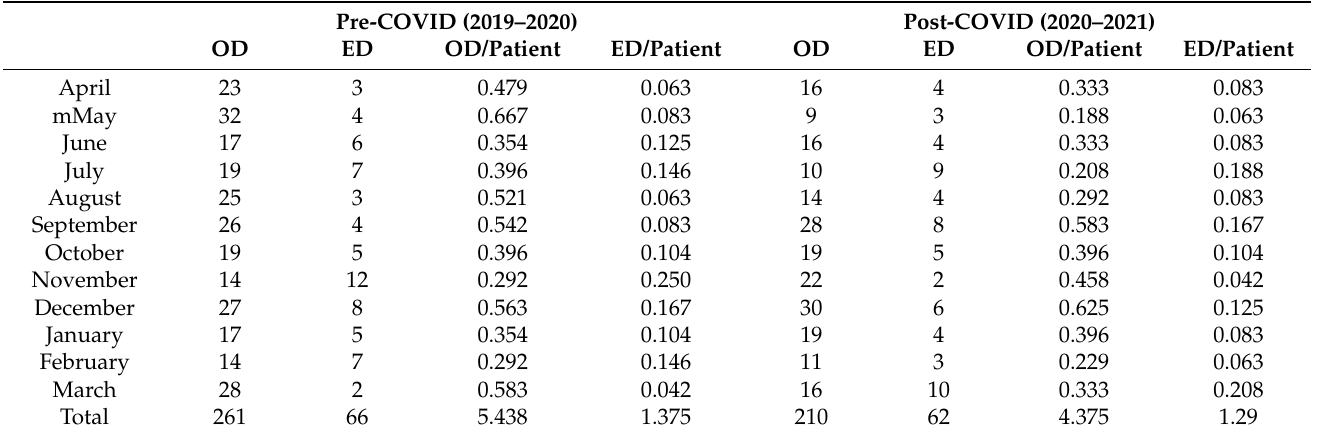
Table 2. Annual medical care visits to the outpatient department during the pre- and post-COVID period.